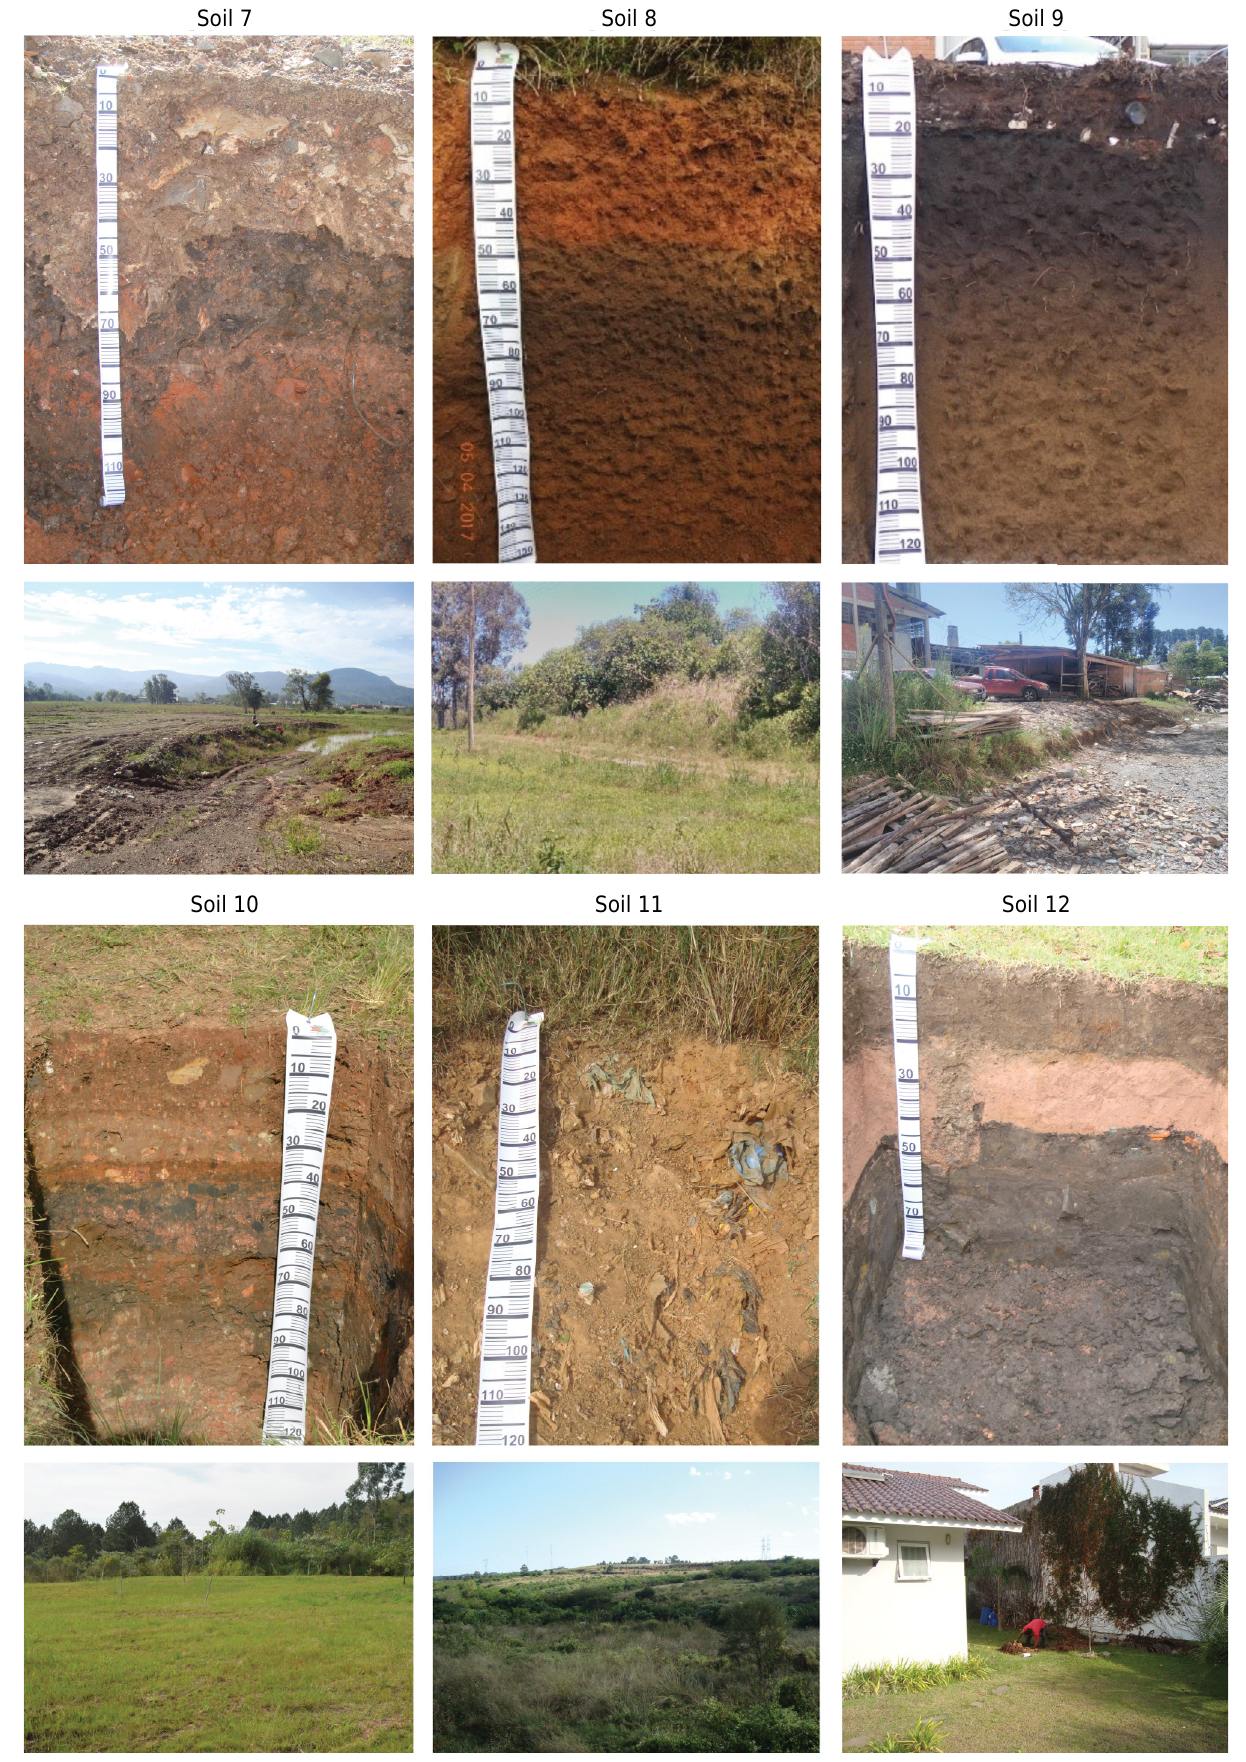
Figure 3. Soil profiles and landscapes (7 to 12) in the urban area of Santa Maria, Rio Grande do Sul State,